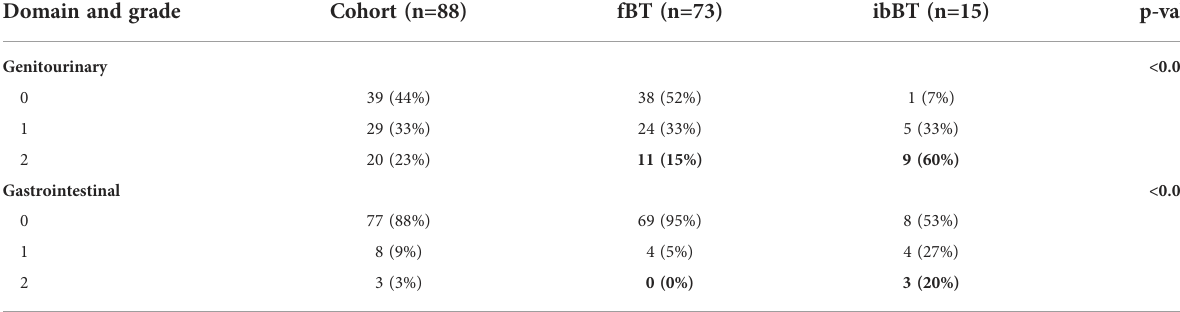
TABLE 3 Toxicity events attributable to salvage brachytherapy (CTCAE grade). Domain and grade